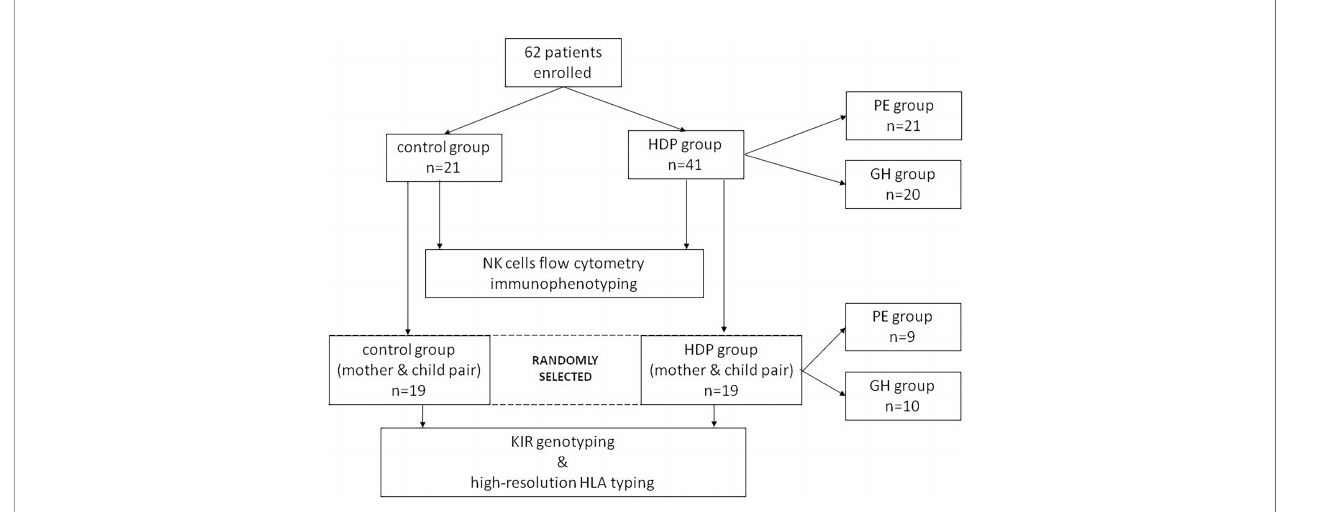
( Figure 3 ). Positive cells were gated using a non-stained sample as a reference or with an FMO gating strategy.